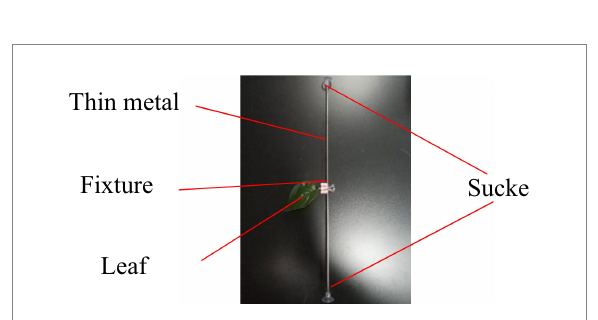
FIGURE 8 Schematic diagram of leaf sample layer division.